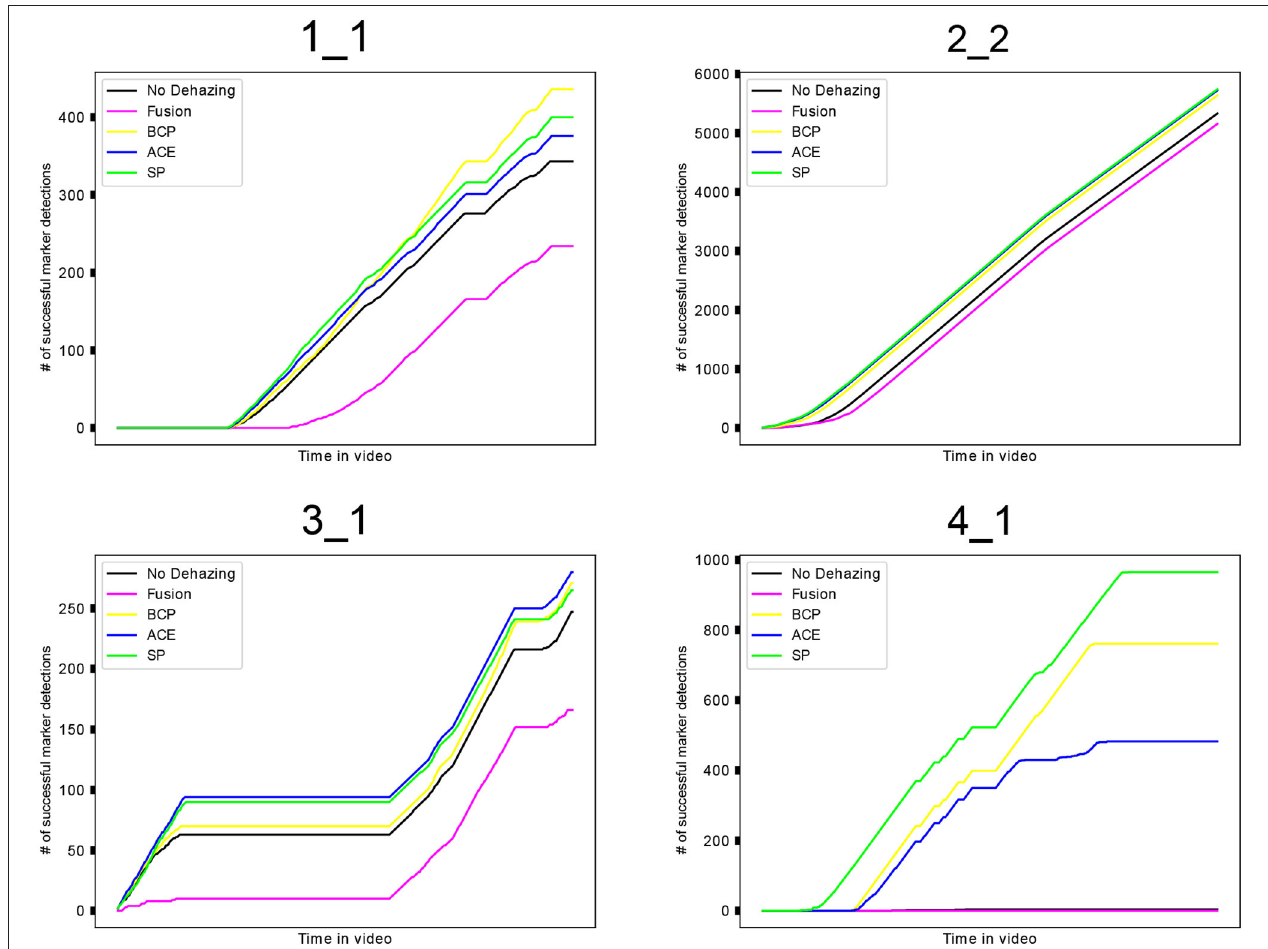
FIGURE 8 | Results of marker detection shown on graphs. Each test video group is represented by one video (labeled on top). Graphs are showing the cumulative number of successful marker detections in videos for each dehazing method or no dehazing,